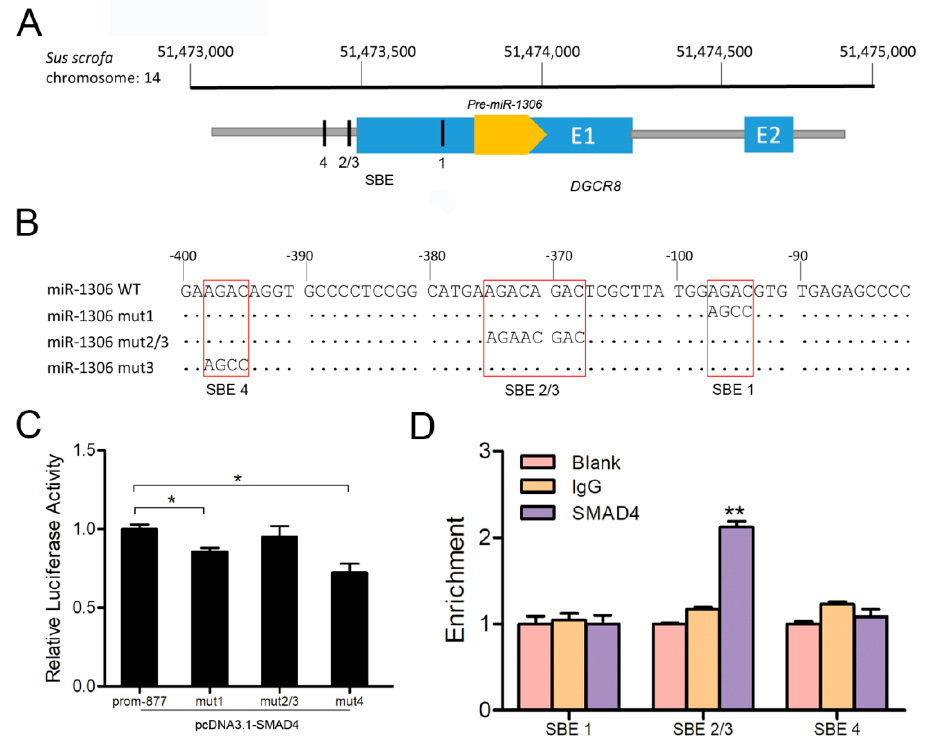
Figure 5. SMAD4 acts as a transcription factor and directly binds to the miR-1306 promoter. ( A ) Schematic diagram depicting the genome locations of miR-1306 (yellow) and its host gene DGCR8 (blue), and the four potential SMAD4-binding sites are shown inside the black rectangles. ( B ) The luciferase reporter vectors containing porcine miR-1306 promoter with wild-type (prom-877) or mutant-type SBE motifs, shown in the red boxes. ( C ) pcDNA3.1-SMAD4 was co-transfected with recombinant vectors in ( B ) into GCs and luciferase activity assay was performed. ( D ) Chromatin immunoprecipitation (ChIP) assays and the enrichment were determined by qRT-PCR. Each experiment was independently repeated thrice and results are presented as mean ± SEM. * means p < 0.05 and ** means p < 0.01.